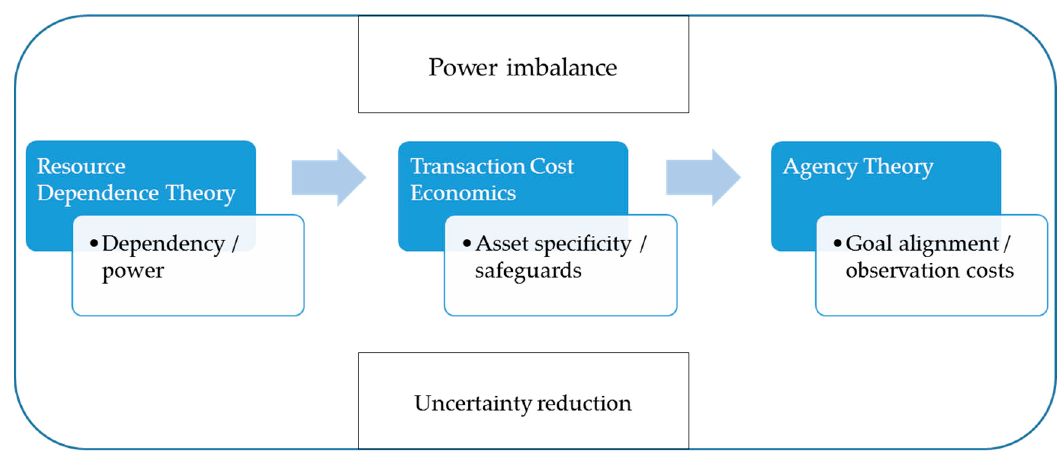
Figure 1. Holistic framework for the explanation of complex inclusive business set-ups.